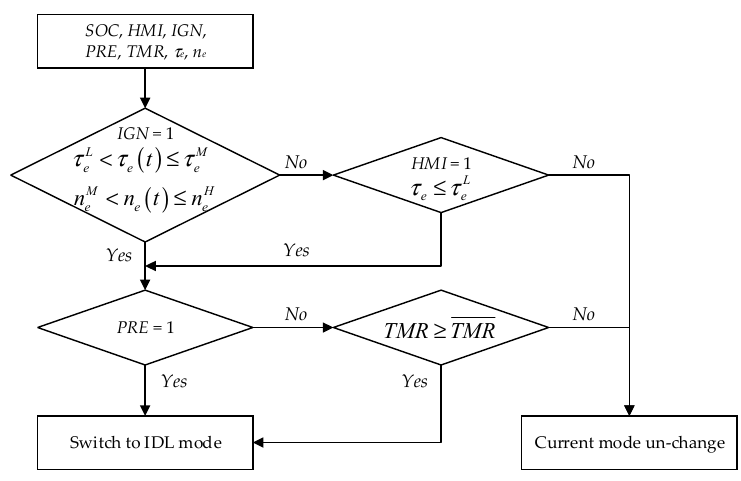
Figure 9. Logics for IDL mode decision.